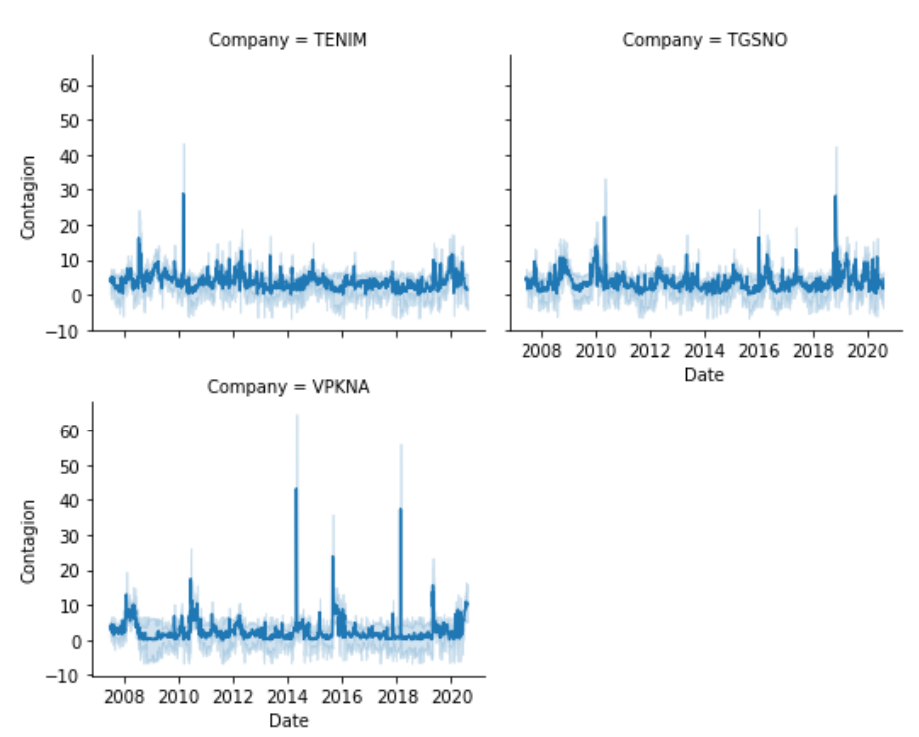
Figure C2. Spillovers (from, to, and net) among companies inside the energy sector for CoVaR measures.